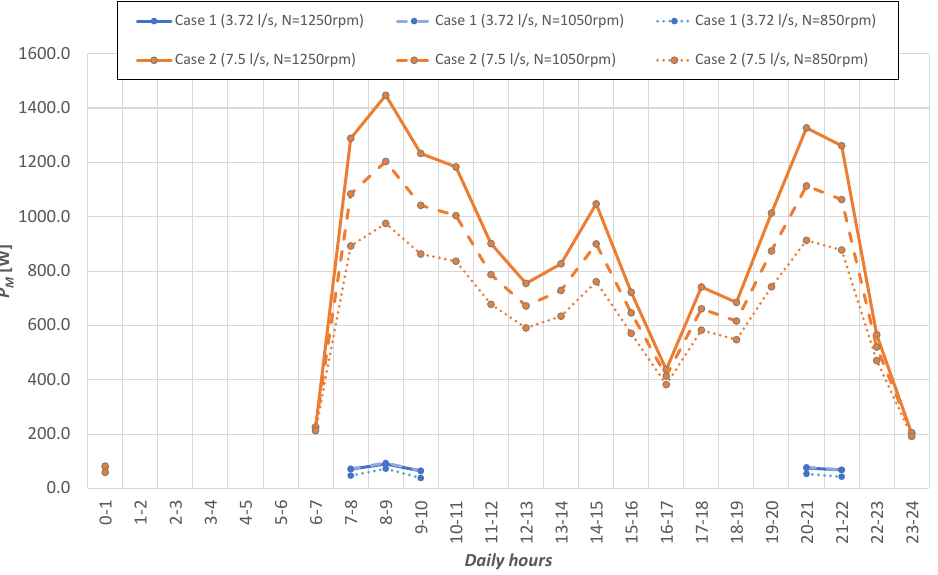
Figure 11. Daily distribution of mechanical power for the investigated cases (blue for µ q = 3.72 L/s and orange for µ q = 7.50 L/s) and PAT speed (solid for N = 1250 rpm, dashed for N = 1050 rpm, and dotted for N = 850 rpm).